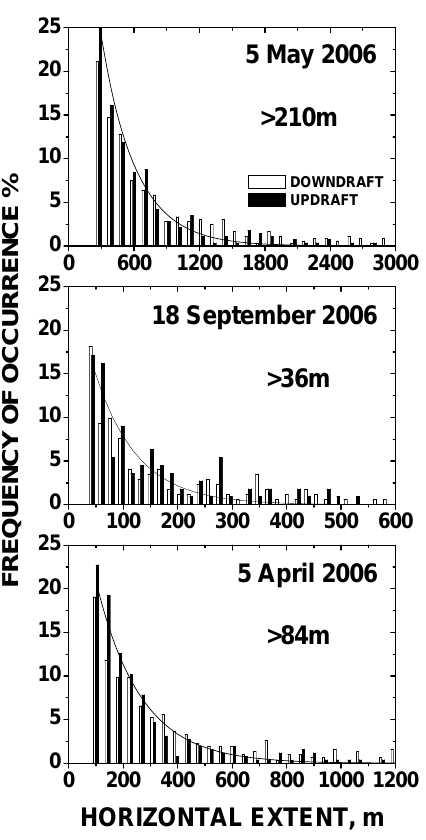
Fig. 9. Frequency of occurrence of updraft (black) and downdraft (white) horizontal extents (observed occurrence duration > 20s times horizontal wind speed) for 10s occurrence duration intervals (20–30s, 30–40s, etc.). The statistical results consider all updraft and downdraft events observed at the 645, 870, and 1170m height levels on 5 April, 12:00–16:45LT, and on 5 May and 18 September, 12:00–17:00LT. Curves (exponential functions) are fitted to the ob- served updrafts and downdrafts. Fit parameters are given in Table 2.